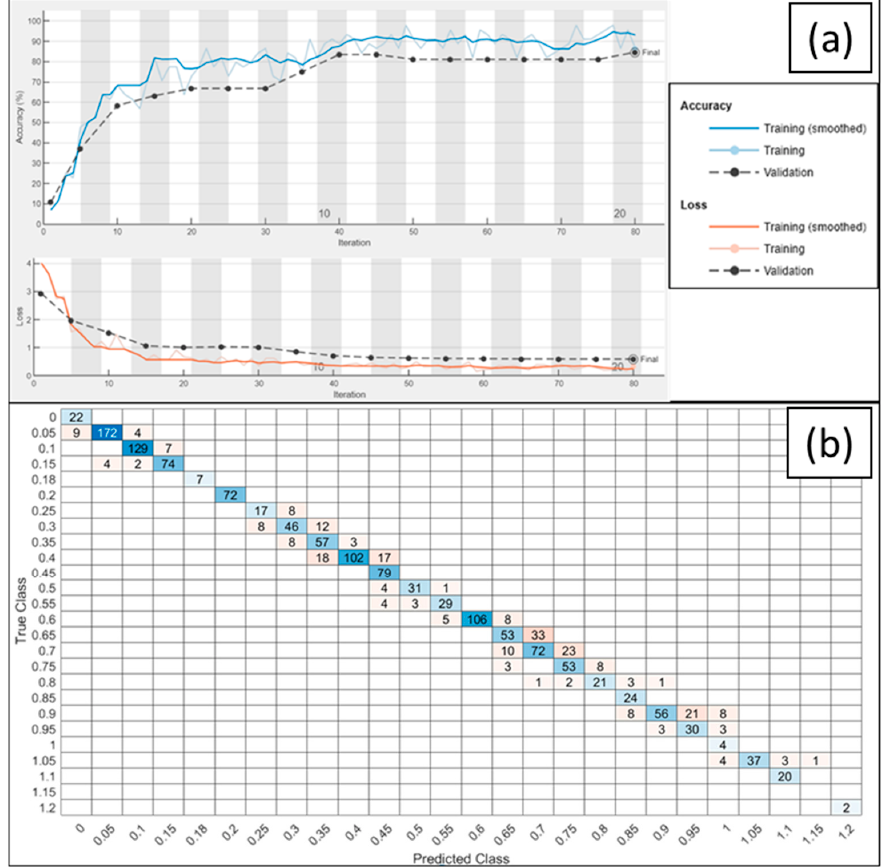
Figure 8. Metrics of the CNN; ( a ) accuracy and loss reached by the CNN models for the tide assessment on the frames sampled by webcams of MPA of Plemmirio (Siracusa, south-eastern Sicily); ( b ) confusion matrix of all true classes (obtained from spatial reference) and CNN predicted classes (tide classes predicted by CNN).